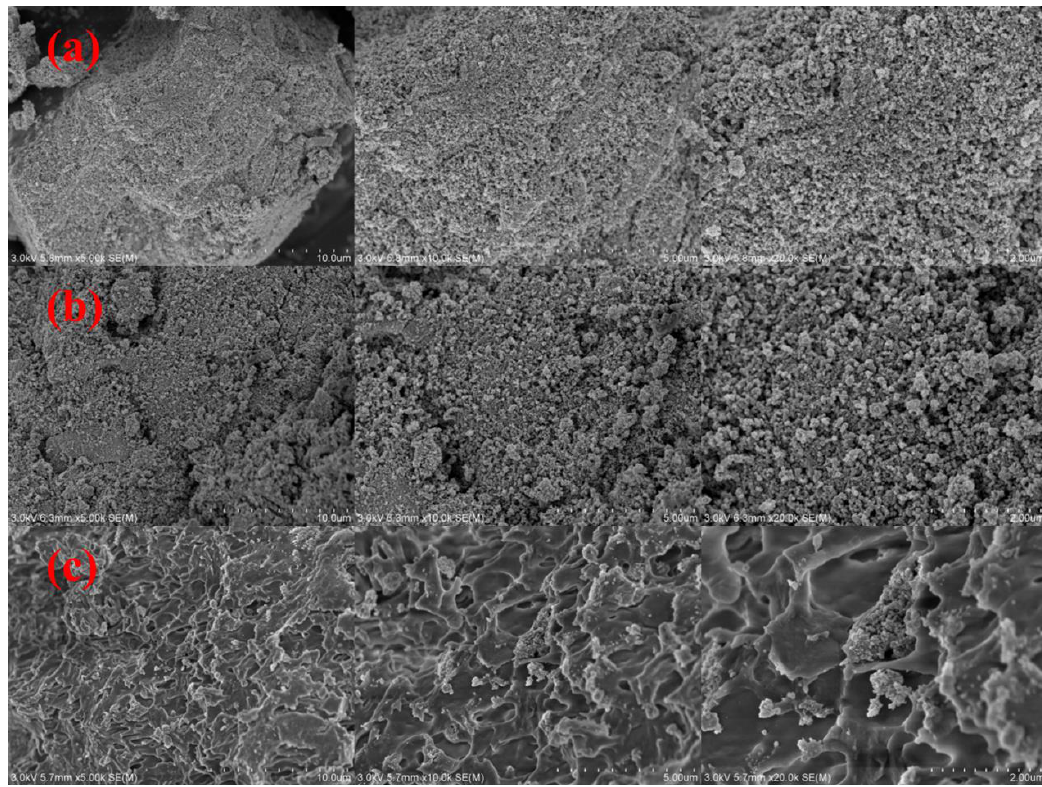
Figure 1. SEM images of magnetic flocculants: ( a ) MF, ( b ) MFM, and ( c ) MF@AA. Physico-chemical properties and the presence of MF@AA on the modified surfaces can be characterized by FTIR, XRD, XPS and VSM techniques, and the obtained data are presented in Figure 2. FTIR spectra of MF, MFM and MF@AA are shown in Figure 2a. In the MF@AA sample, the peak at 578 cm − 1 is attributed to Fe–O vibration. Meanwhile, the peak at 1040 cm − 1 is attributed to the -CO stretching vibration peak and the symmetric stretching vibration peak of the sulfonic acid group (-SO 3 H), which confirms the presence of the modifier on MF@AA. In addition, the symmetrical and asymmetrical stretching vibration peaks of the sulfonic acid group (-SO 3 H) are located at 1187 cm − 1 [18]. The peak at 1040 cm − 1 is commonly present in all MF, MFM and MF@AA samples, and it